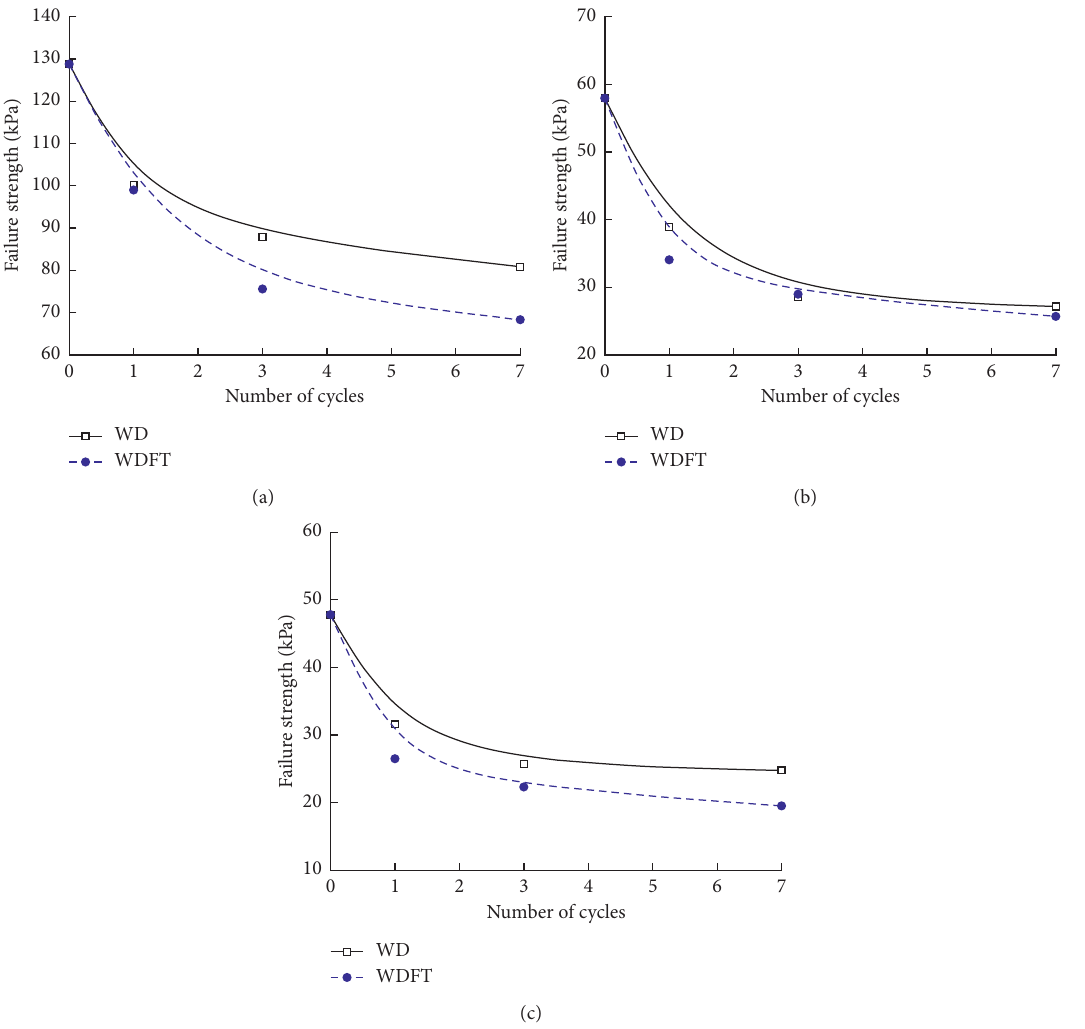
Figure 13: Curves of failure strength variation with cycles. (a) Dry range I. (b) Dry range II. (c) Dry range